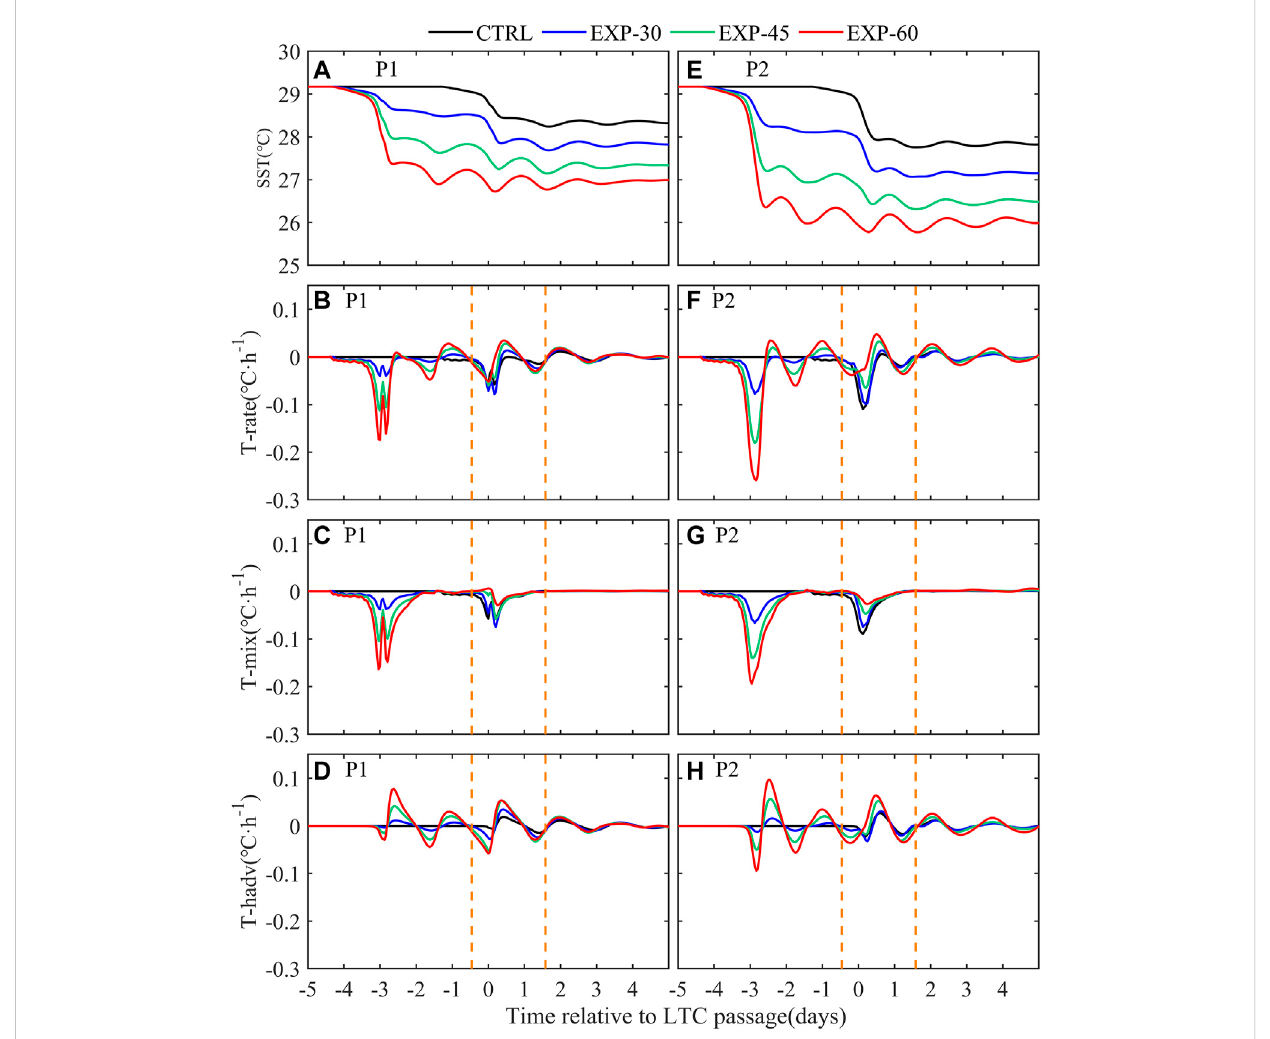
FIGURE 9 The temporal evolutions for the sea surface temperature, local tendency of SST (T-rate), the vertical mixing (T-mix), and the horizontal advection (T-hadv) at P1 and P2 in the CTRL, EXP-30, EXP-45 and EXP-60 experiments. Day 0 refers to the day of the LTC arrival on the local position. The black, blue,gray,andredlineslabelthedifferentidealizedexperiments.Theorangedashedlinesdonatetheperiodsduringwhichthecontributionsofeachterm in Equation 3 to the LTC-induced SST cooling are